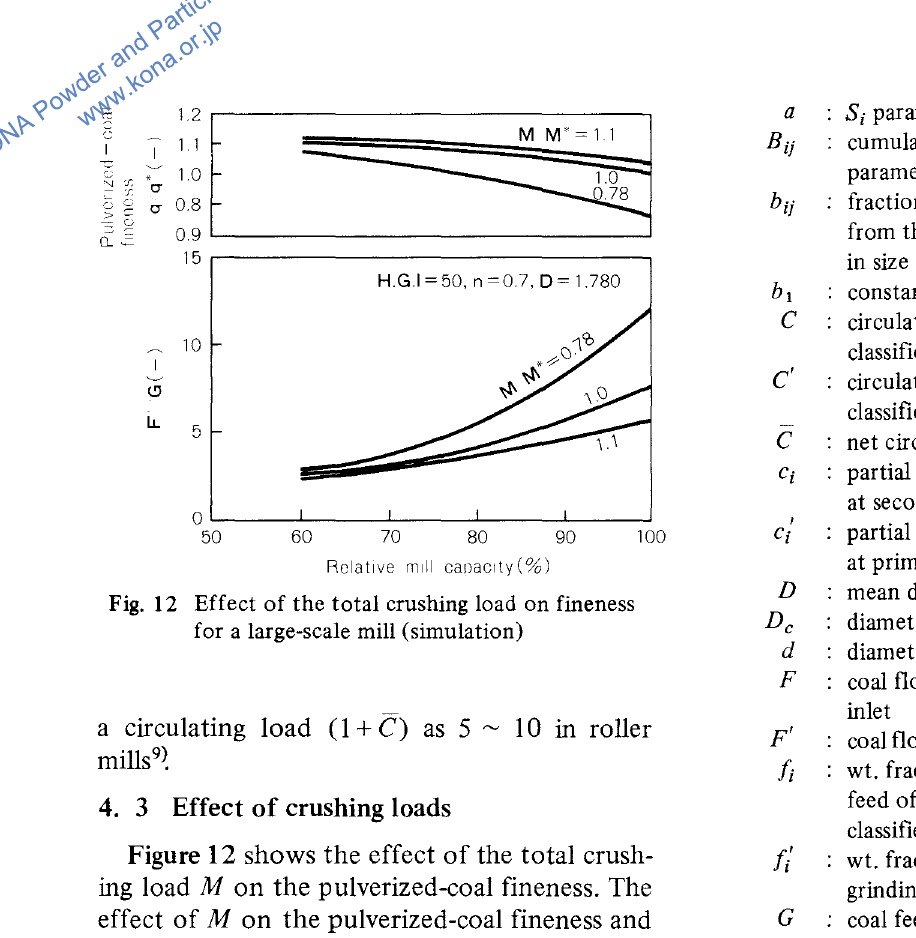
a circulating load ( 1 + C) as 5 ~ 1 0 in roller mills 9